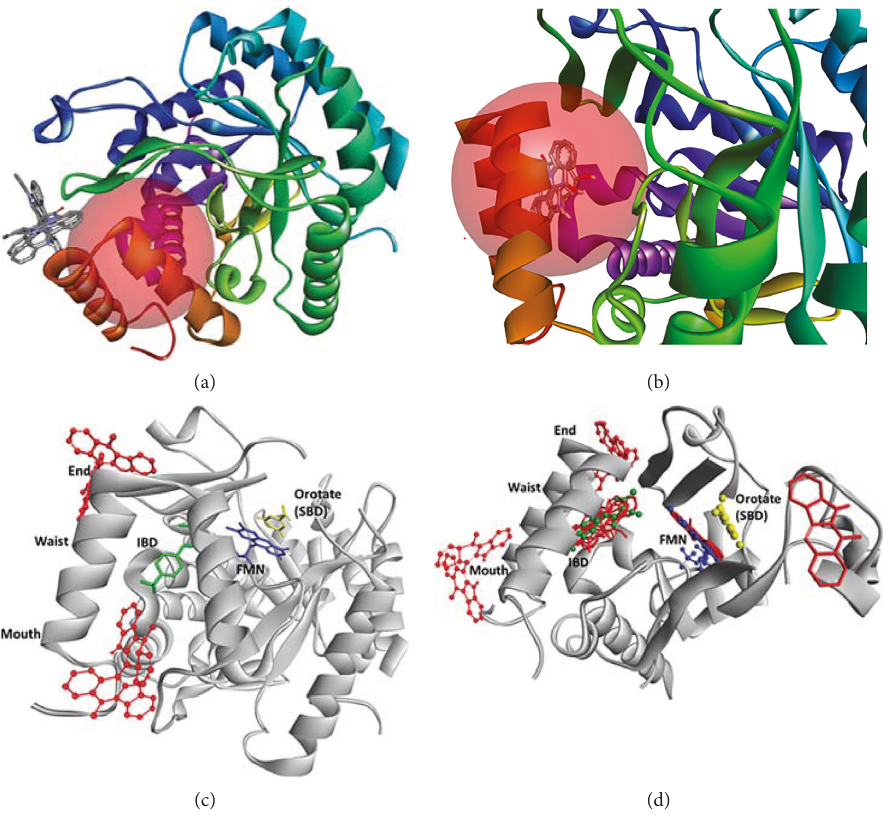
Figure 8: (a) Binding poses of biscryptolepine, cryptolepicarboline, cryptoquindoline, and cryptospirolepine outside of the inhibitor binding domain (IBD is shown as a sphere object). (b) Binding poses of cryptoheptine, cryptolepinone, and hydroxycryptolepine within the binding region shown as a sphere object. (c) Biscryptolepine (red carbon spheres) binding at the end and mouth regions of the quinone- binding tunnel. (d) Overall binding of planar group of alkaloids (cluster of red models) showing preference for both the teriflunomide (green sphere ball and stick model) and flavin mononucleotide (FMN; blue sphere ball and stick model) binding